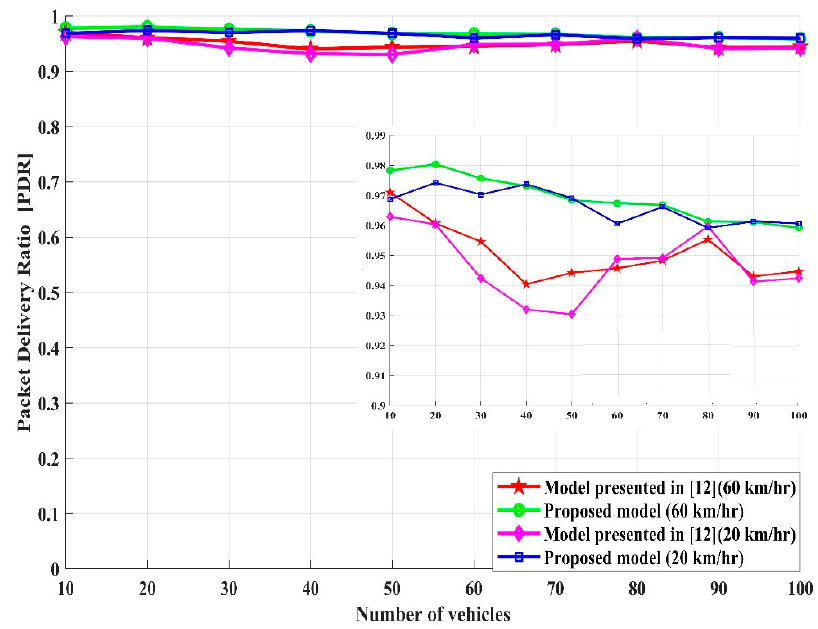
Figure 8. System throughput vs. number of vehicles.